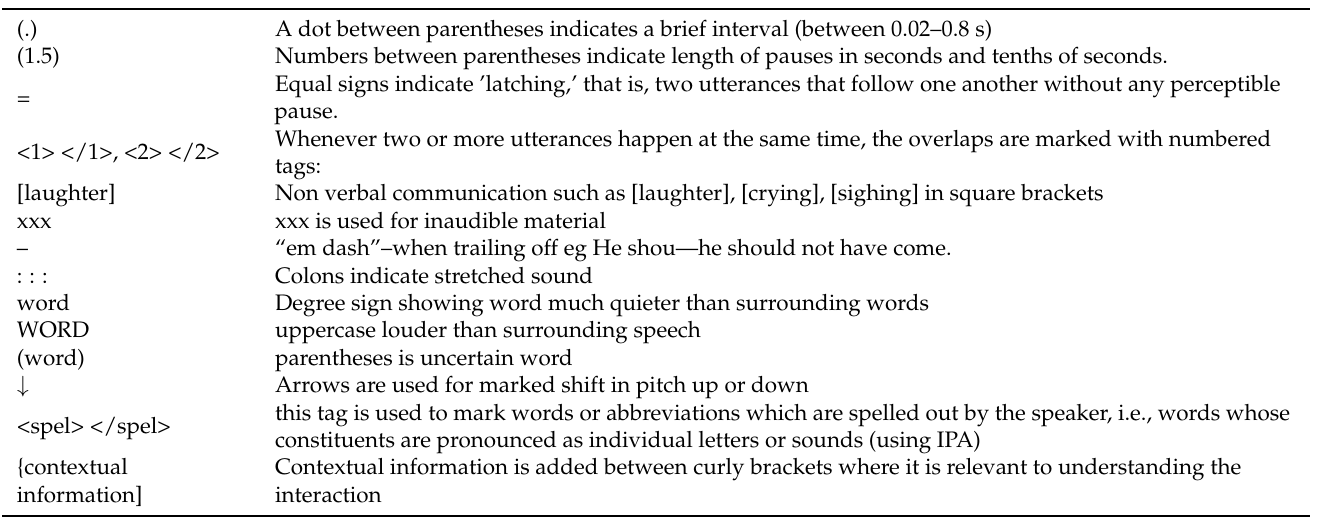
Table A1. Transcription conventions adapted from (Jefferson 2004).